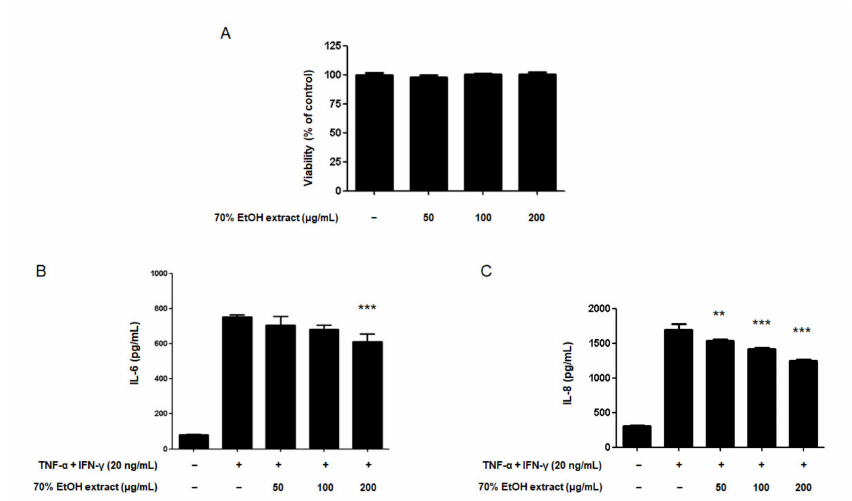
Figure 2. Effects of the 70% EtOH extract from Cudrania tricuspidata on the viability of HaCaT cells ( A ) and, IL-6 ( B ) and IL-8 ( C ) production in HaCaT cells stimulated with TNF- α + IFN- γ . ( A ): The cells were incubated with the indicated concentrations for 24 h; ( B ): cells were pre-treated with the 70% EtOH extract for 3 h and stimulated with TNF- α + IFN- γ for 24 h. Each value represents the mean ± SD. ** p < 0.01 and *** p <0.001 as compared with TNF- α + IFN- γ only.